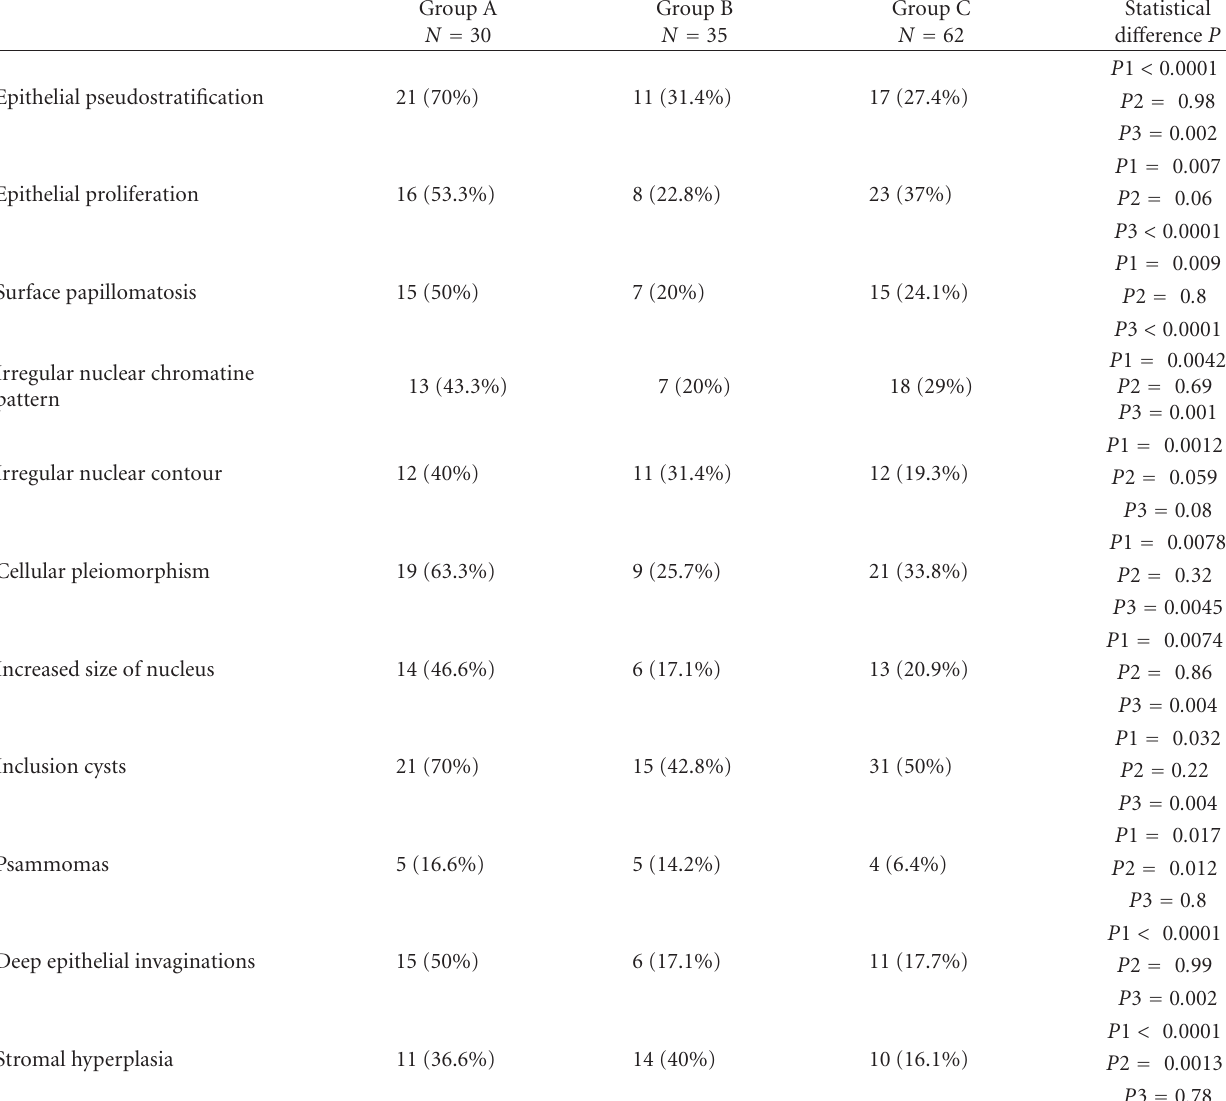
Table 3: Comparison of respective frequencies of the 11 histopathologic abnormalities in our dysplasia scoring